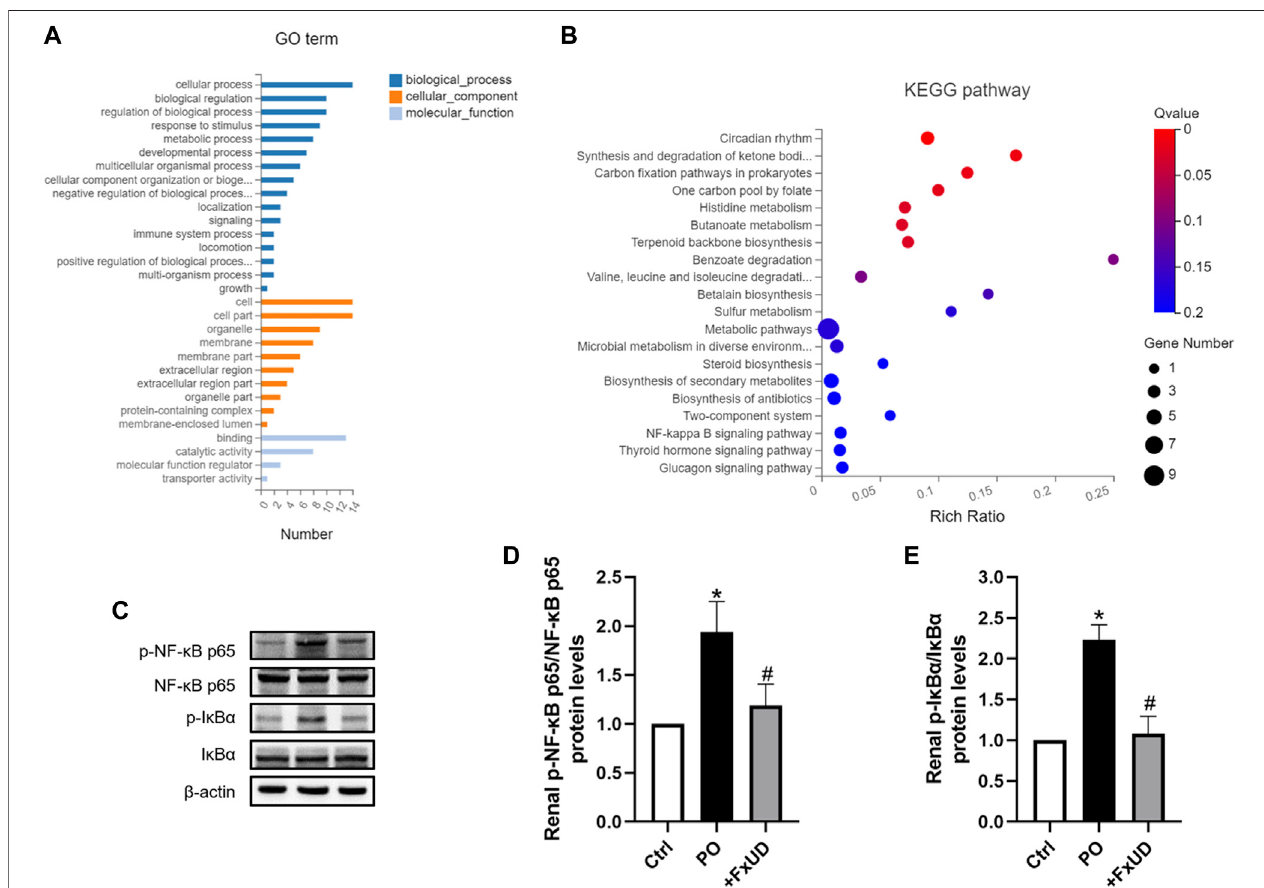
FIGURE7 | FxUD attenuates uric acidinduced in fl ammation bysuppressing NF- κ Bsignaling pathway inthe kidney ofmice with hyperuricemia. (A) Geneontology analysis. (B) The scatter plot for KEGG enrichment results. (C) Representative Western blot bands were shown. (D) Graphic presentation of relative p-NF- κ B p65 and normalized to NF- κ B p65 ( n (cid:1) 5). (E) Graphic presentation of relative p-I κ B α and normalized to I κ B α ( n (cid:1) 5). Values are expressed as the means ± SD. * p < 0.05 vs. Ctrl, # p < 0.05 vs. PO.